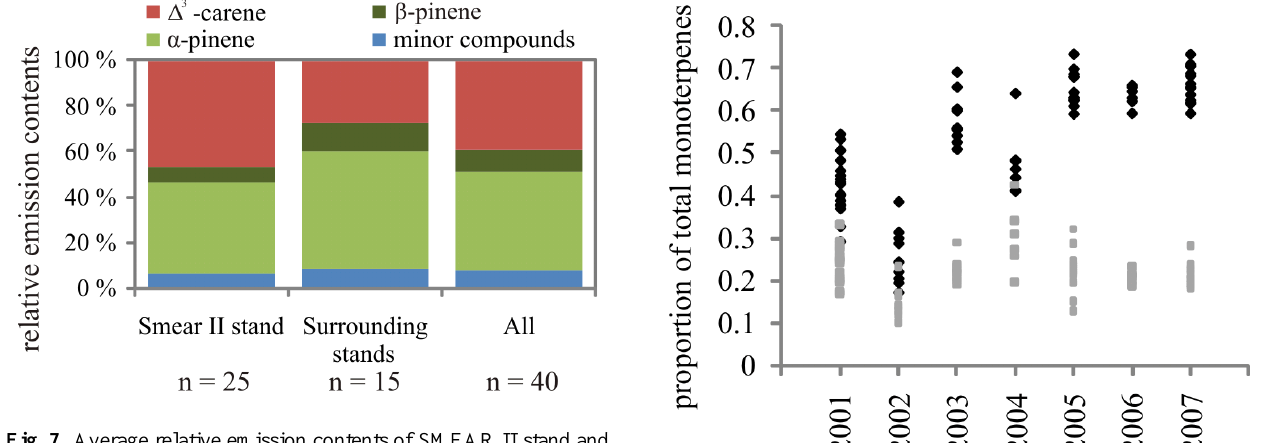
the surrounding stands, and all 40 sample trees. n =number of trees